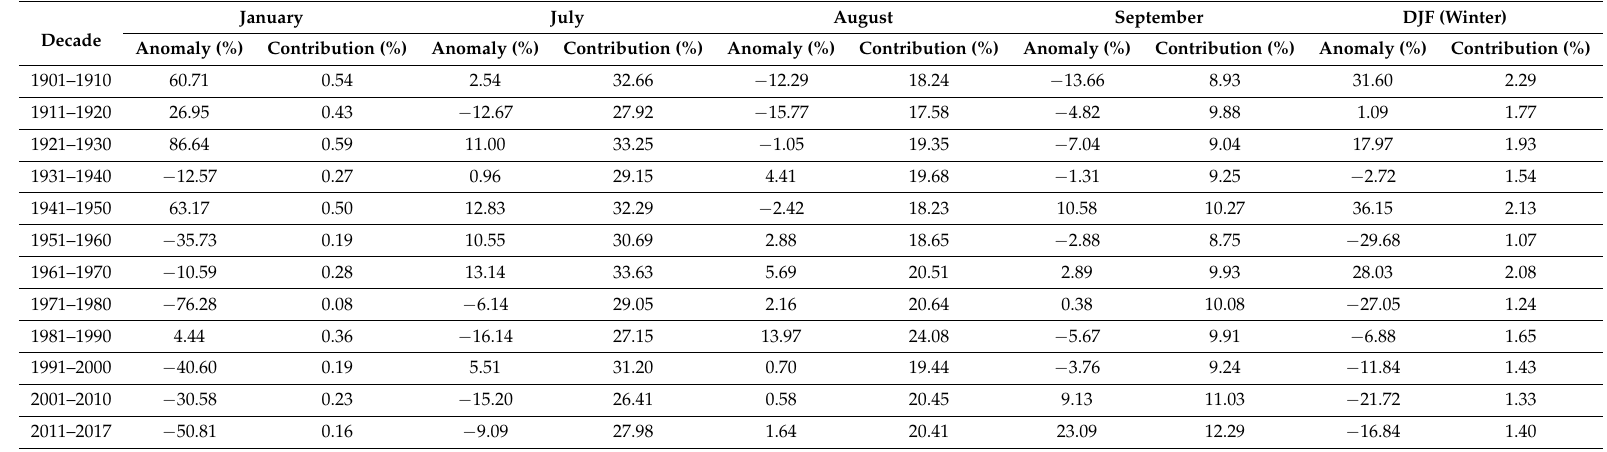
Table 4. Decadal anomaly percentage of rainfall and contribution of periodic rainfall with respect to the normal rainfall for the period